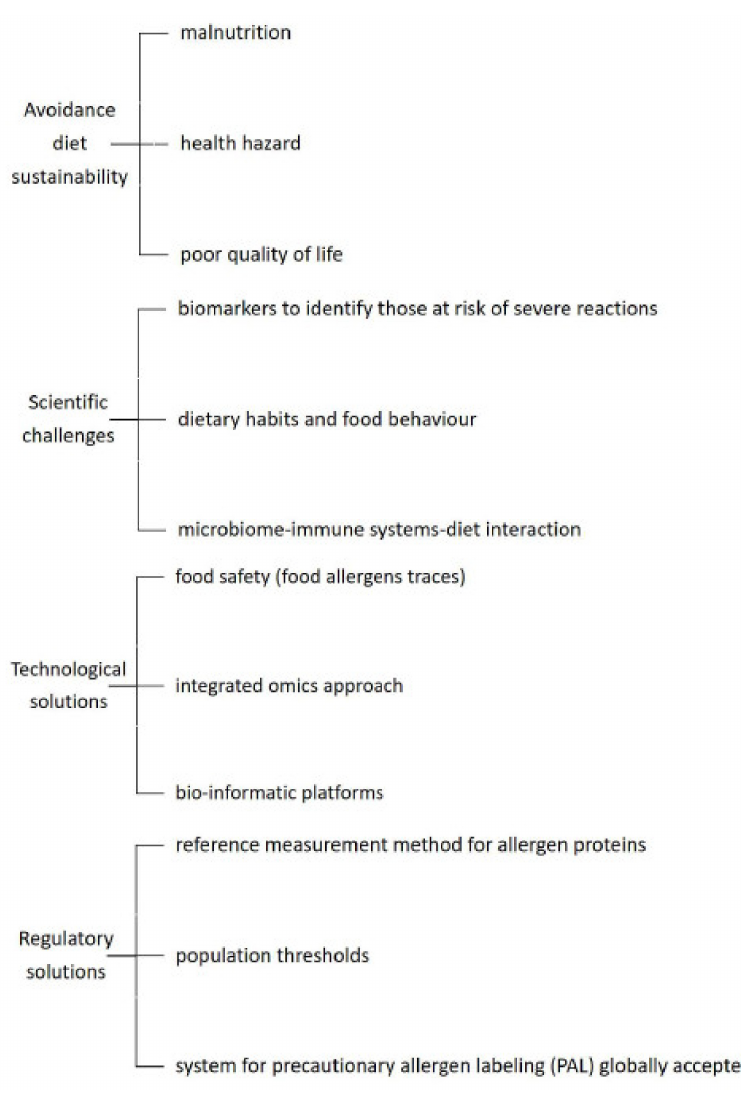
Figure 1. Nutrition approach: unmet